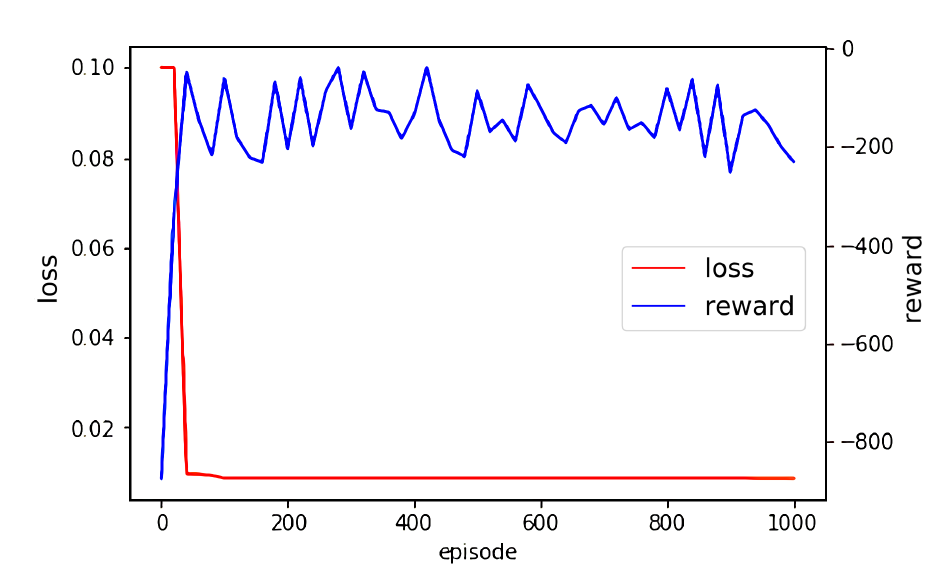
Figure 14. Convergence curves of ANNs.